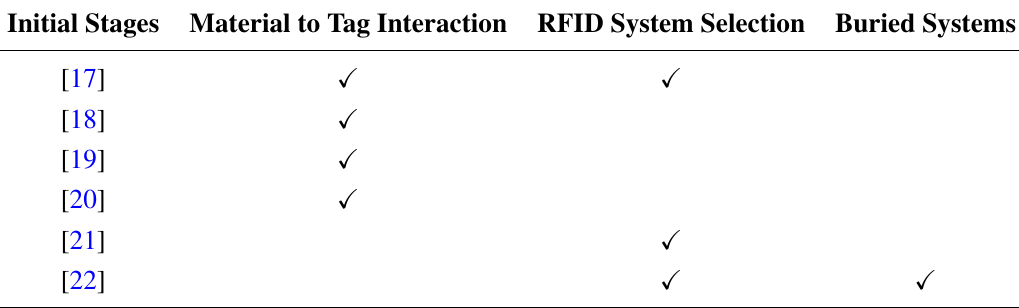
Table 3. Works dealing with the initial stages of the construction